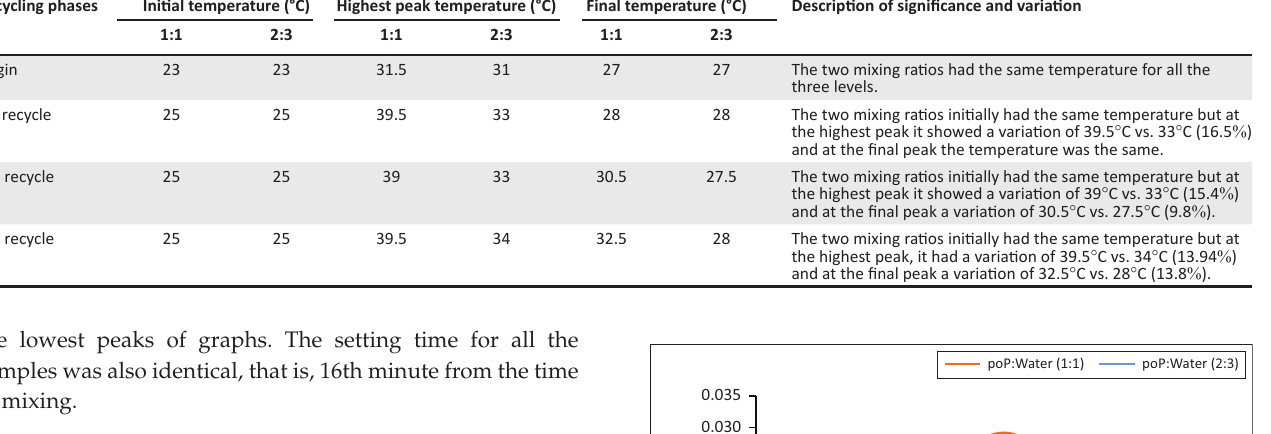
TABLE 1: Increase in temperature with time and the peaks reached . Recycling phases